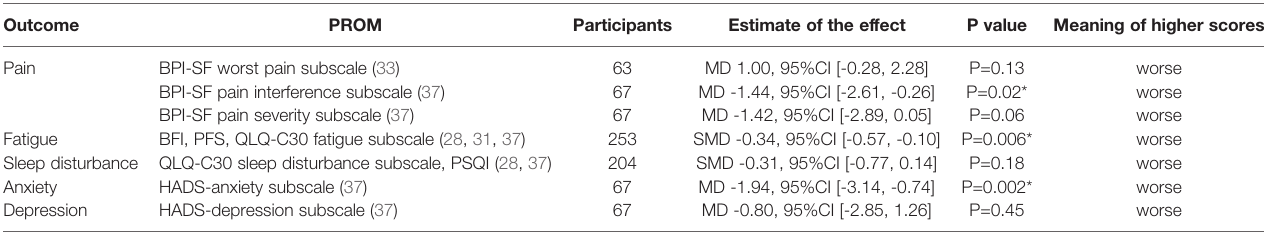
TABLE 5 | The pooled analysis results of acupuncture versus comparators for BC treatment-related symptoms at extended follow up time. Outcome